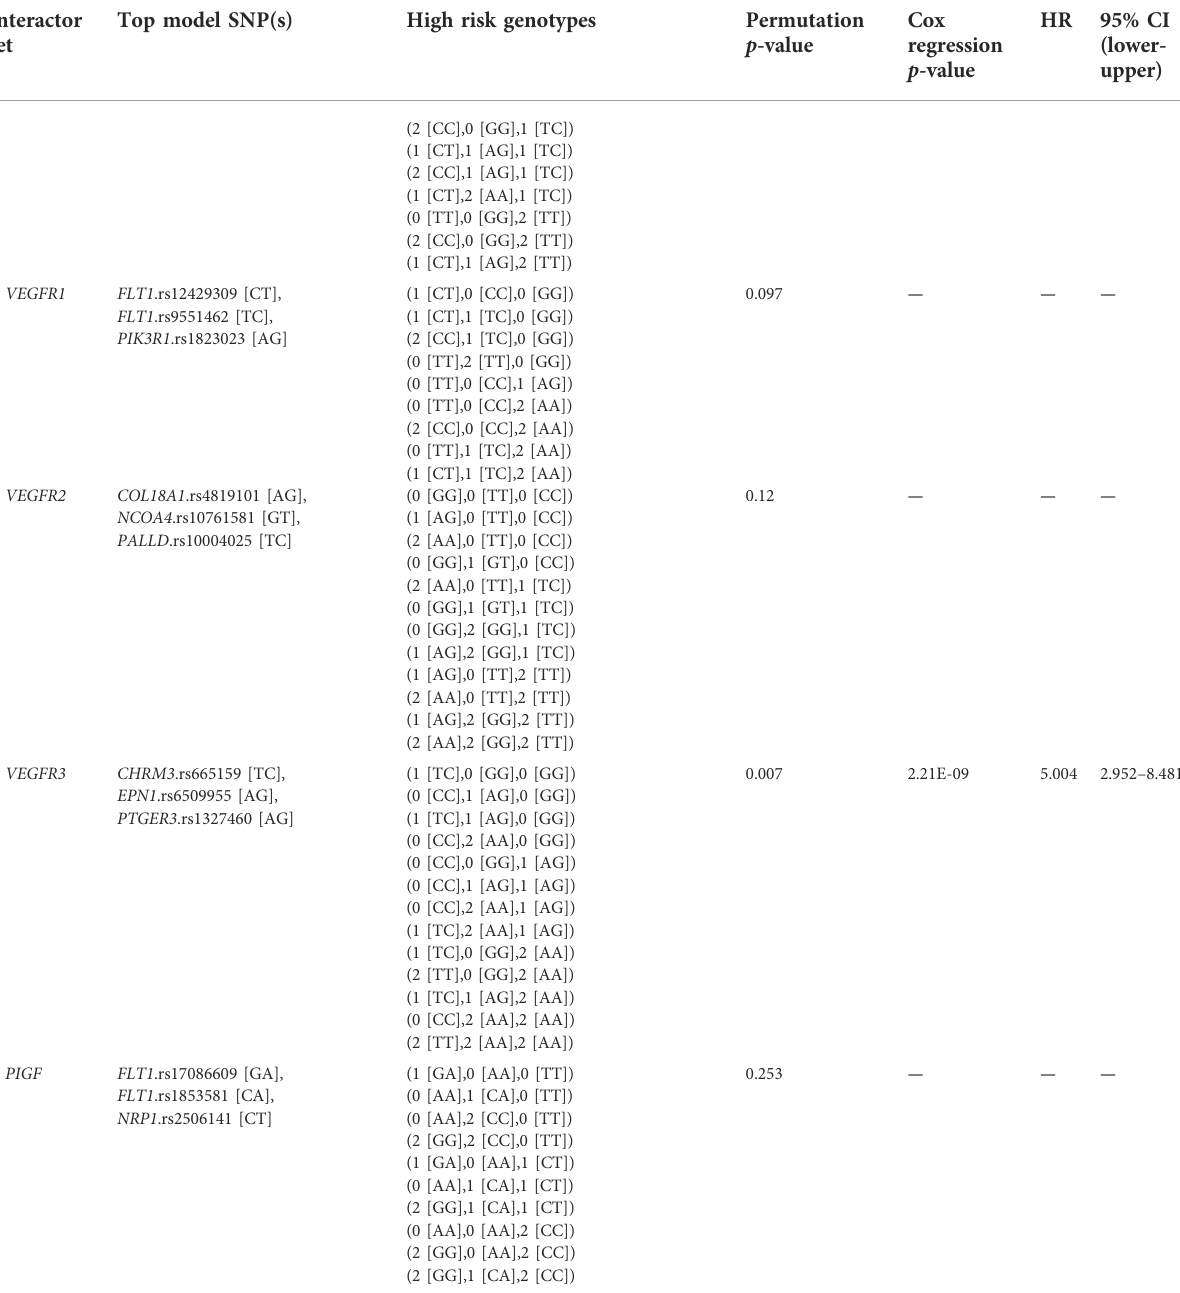
TABLE 3 ( Continued ) Permutation testing and multivariable Cox-regression analysis results for the top Cox-MDR models in the VEGF interaction network set analyses (disease speci fi c survival). Interactor